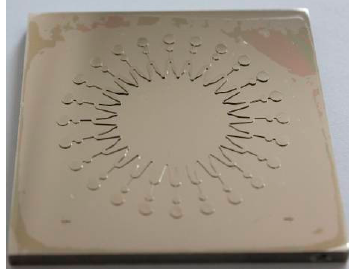
Figure 9. The microfluidic chip mold.